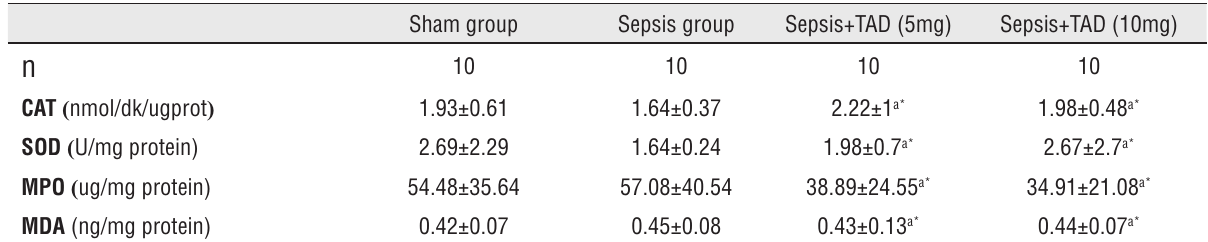
Arrow heads indicate Mac387 positivecells. G = glomerule